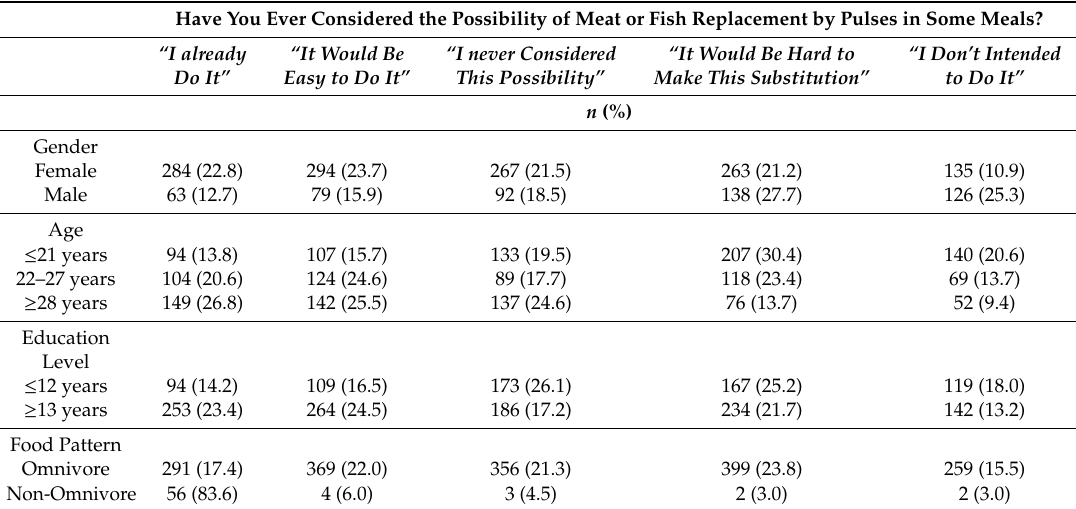
Table 4. Willingness for the replacement of meat or fish by pulses.